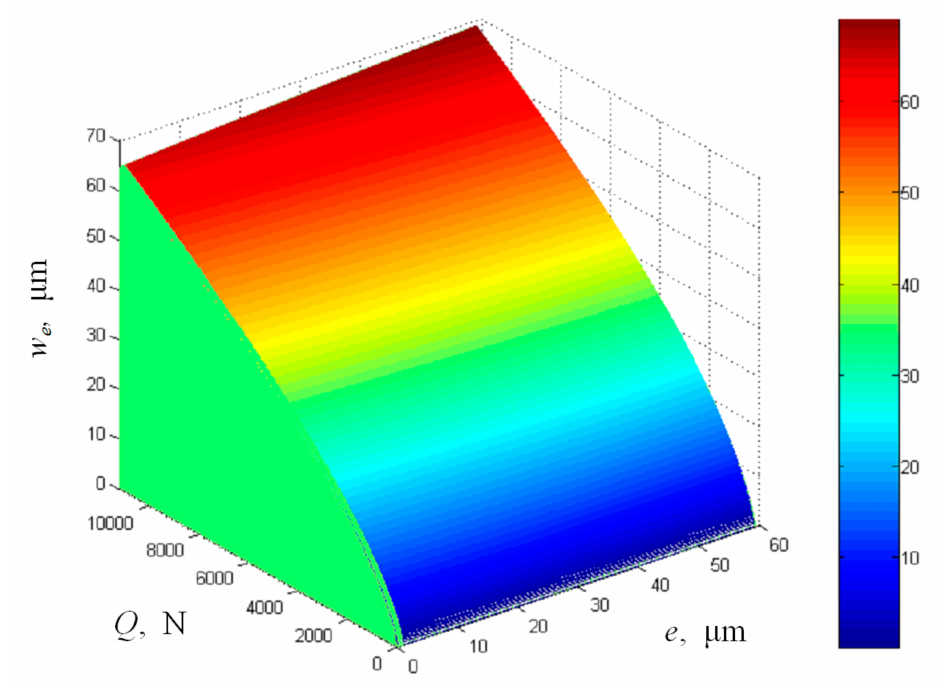
Figure 7. Three-dimensional dependence of bearing deflection ( w e ) on the size of internal radial clearance ( e ) and level of external load ( Q ), for the BSE position of 6206-single-row ball bearing.